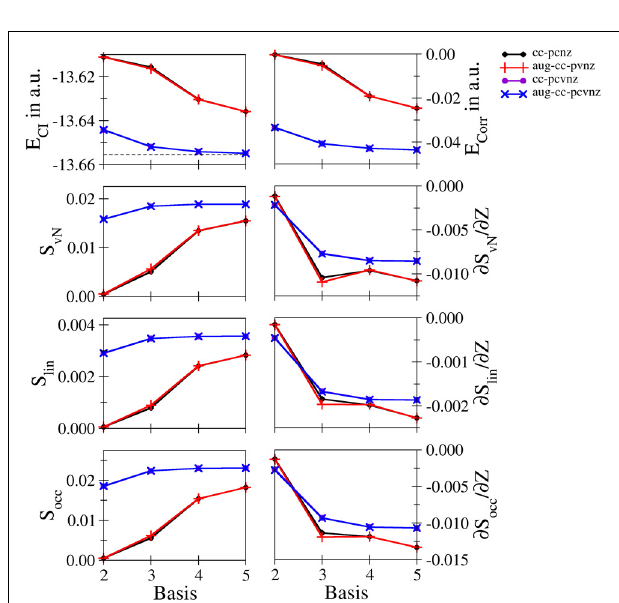
FIGURE 5 | Total and correlation energy E CI and E corr in atomic units; von Neumann S vN , linear S lin and occupation number S occ entropies and their derivative with respect to the nucleic charge Z obtained for H − , He, Li + and Be 2 + at the FCI level using the 3-21G, cc-pV5Z and the ’best’